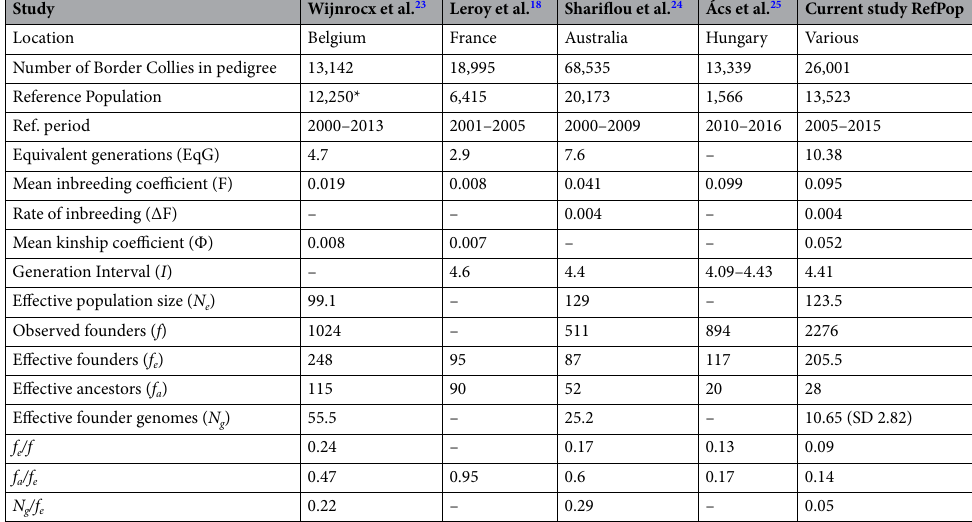
Table 1. Summary of genealogical estimates of diversity in Border Collies from previous studies and a comparison to the present study. * Authors reported mean number of pups per year for 2003 to 2012. This value was multiplied for the length of the reference period.